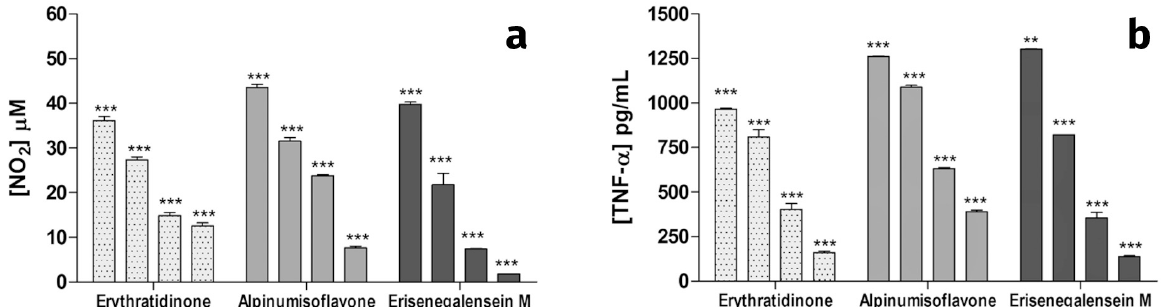
Figure 2. Effect of isolated substances from Erythrina verna on production of proinflammatory mediators (NO and TNF-α) by LPS-stimulated RAW 264.7 macrophages. Macrophages RAW 264.7 were plated and stimulated with 1.0 µg/mL de LPS for 24 h at 37 ºC with or without isolated substances from E. verna (0.8, 4, 20 and 100 µg/mL). ( a ) Nitrite was determined by the method of Griess reaction. Macrophages not treated and not stimulated with LPS were used as negative control; and macrophages stimulated with 1 μ g/mL LPS (56.1 ± 1.5 µg/mL) and not treated as positive control. L- N MMA was also used as positive control at 20 μ g/mL inhibiting 51.4 ± 2.4 % NO production. ( b ) In the TNF-α assay, TNF-α values determined in untreated and only LPS-treated cell cultures were 1.1 ± 0.1 pg/ mL and 1428.6 ± 6.6 pg/mL, respectively. The results presented are mean values obtained over three experiments, each done in triplicate. *** p < 0.001, ** p < 0.01 and * p < 0.05 compared to untreated group (0 μ g/mL) determined by Tukey